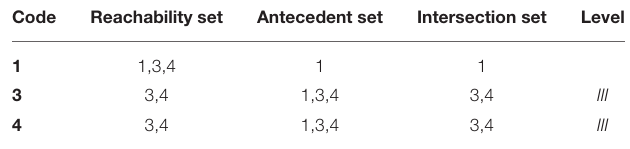
TABLE 8 | Iteration III. Code